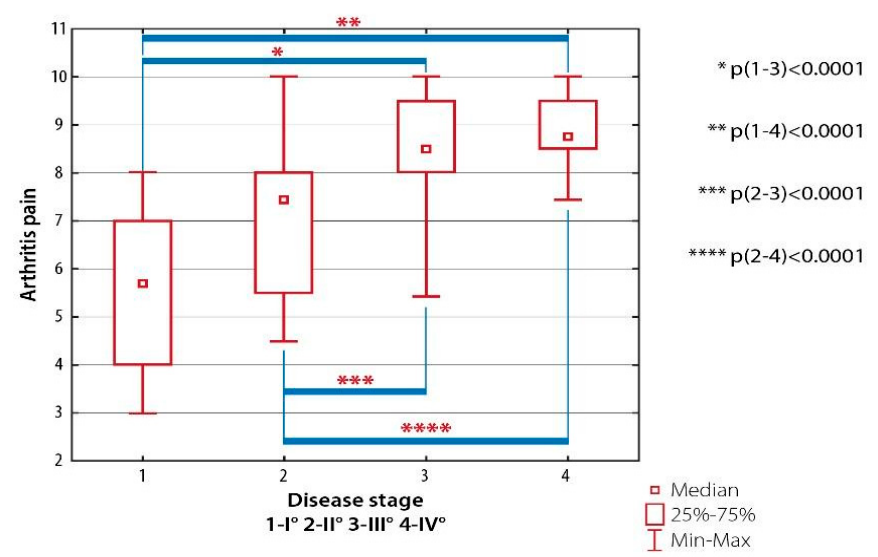
Figure 6. Inter-group differences in the quality of life evaluated with AIMS-2: arthritis pain, depend- ing on the severity of radiological changes (the Steinbrocker classification).